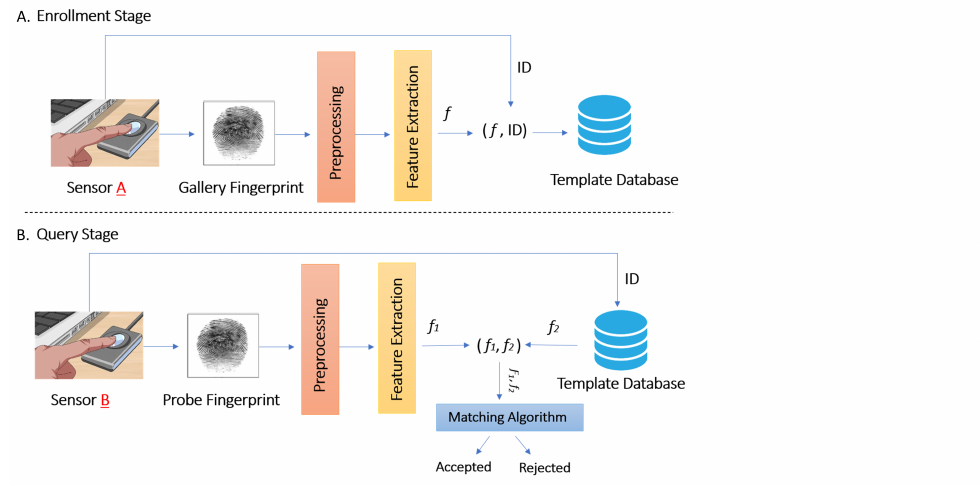
Figure 1. Cross-sensor fingerprint matching